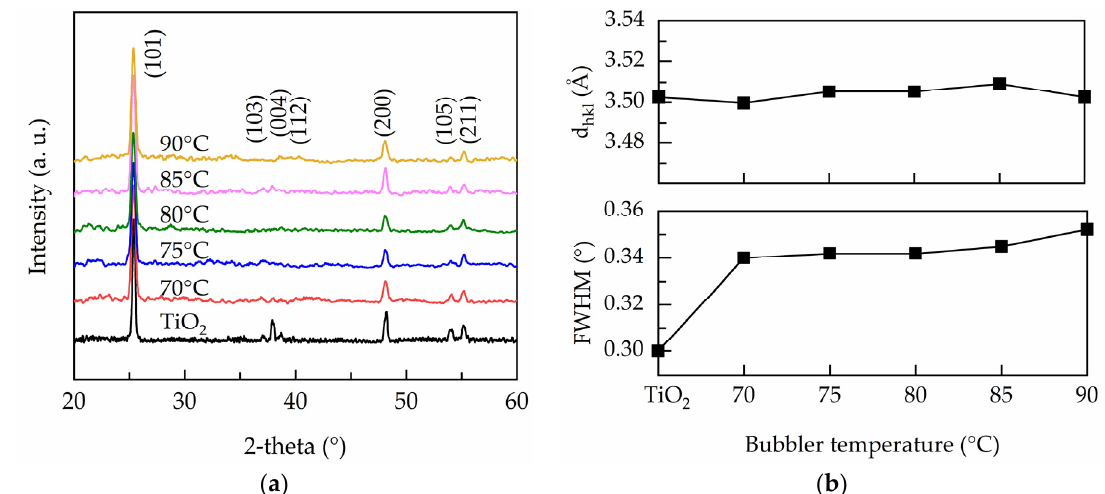
Figure 3. ( a ) XRD pattern, ( b ) interplanar distance and FWHM of the PEALD Ta-doped TiO 2 films prepared at various bubbler temperatures.